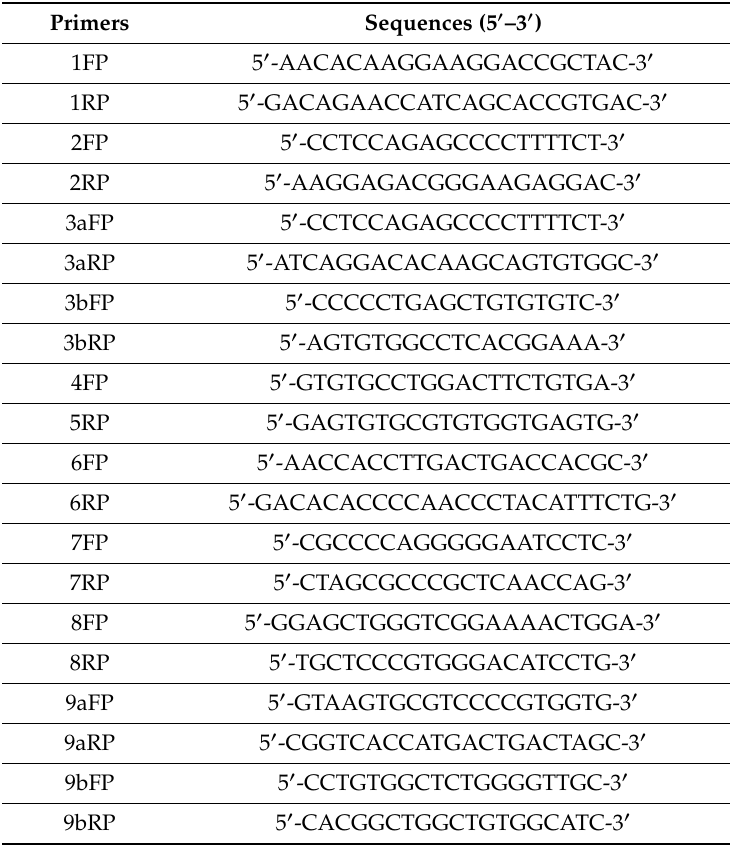
Table 1. Oligonucleotide sequence of primer pairs used for STK11 genetic analysis. Primers Sequences (5 (cid:48) –3 (cid:48)